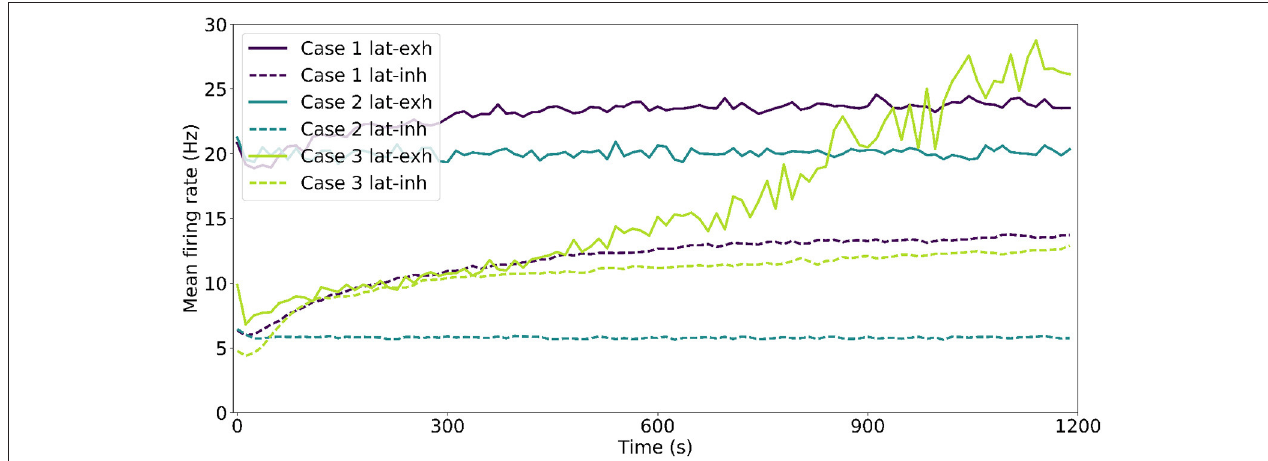
FIGURE 8 | Target layer firing rate evolution throughout the simulation. The instantaneous firing rate has been computed in 1.2 s chunks for simulations where lateral connections are excitatory (lat-exh) and for simulations where lateral connections are inhibitory